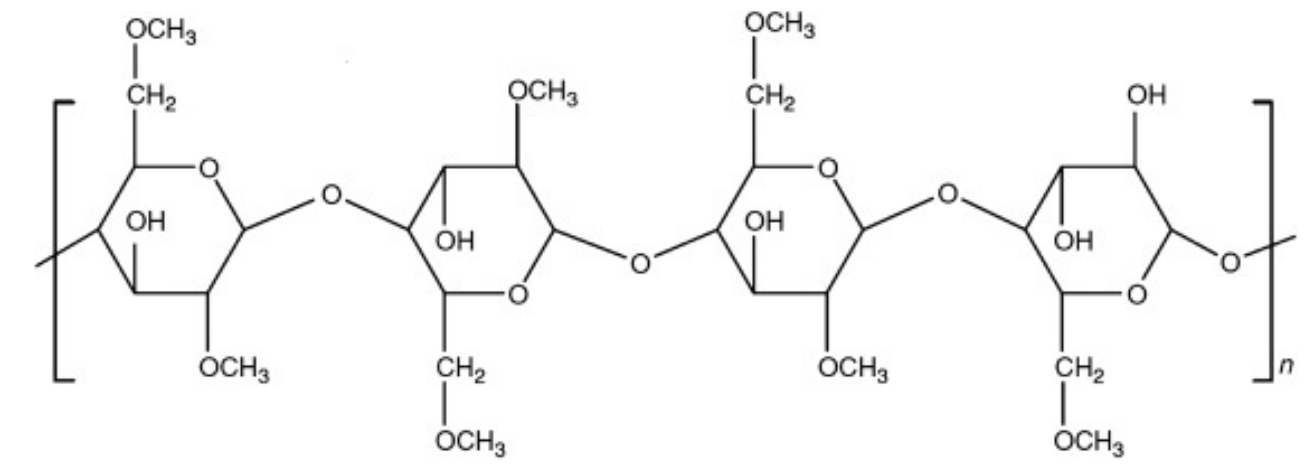
Figure 3. Represents the chemical structure of MC